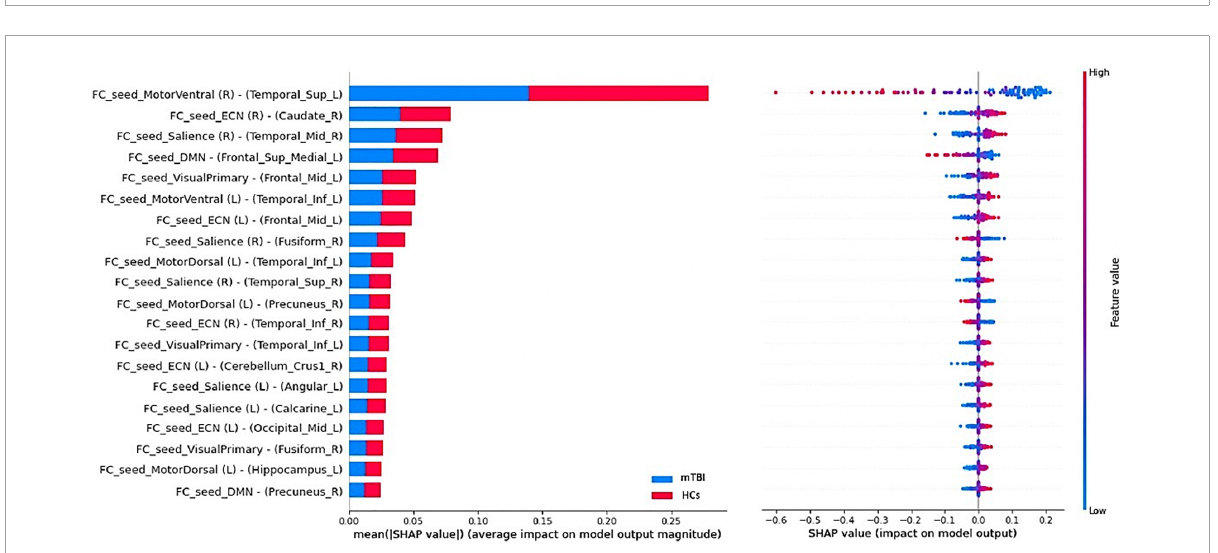
FIGURE7 Summary plot of the top 20 features with the most contribution to the model prediction of the network measures. (Left) The mean absolute Shapley Additive explanations (SHAP) values of the features. (Right) The SHAP values of features in every sample. Each line represents a feature, and each dot visualizes the SHAP value for one subject and corresponding feature. A positive SHAP value indicates an increase in the risk of predicting mild traumatic brain injury (mTBI) and vice versa. The vertical axis represents both the features, ordered by the mean absolute SHAP values and their